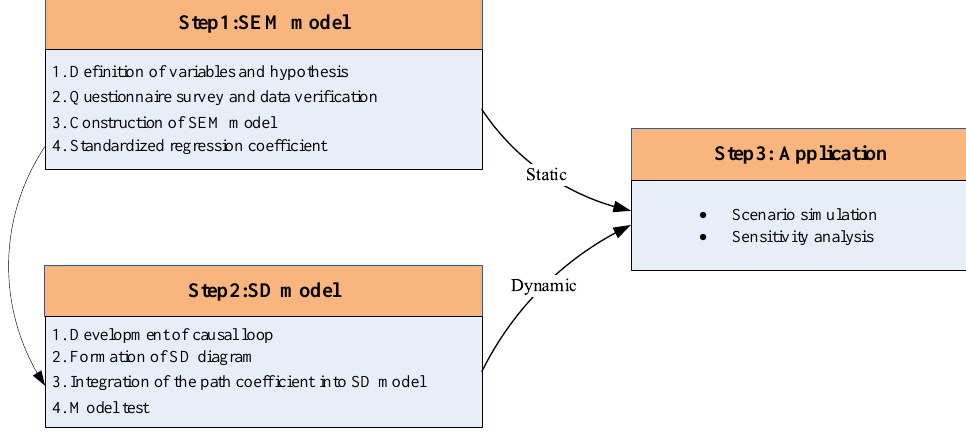
Figure 1. Framework and process of the proposed method.